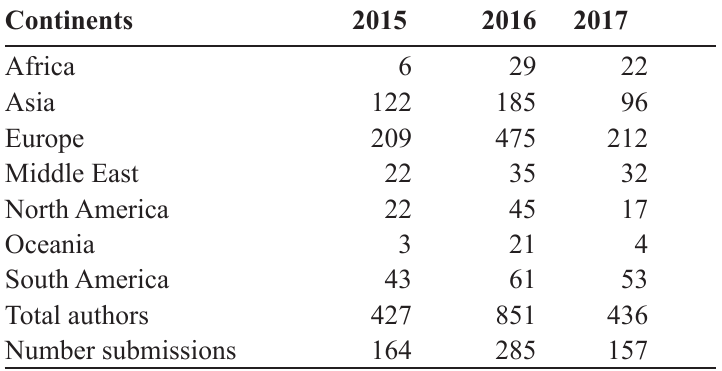
Table 3. Geographic locations of all authors of published papers (not only first or corresponding). Those figures were manually counted because it was an important criteria to understand the authorship of the journal.